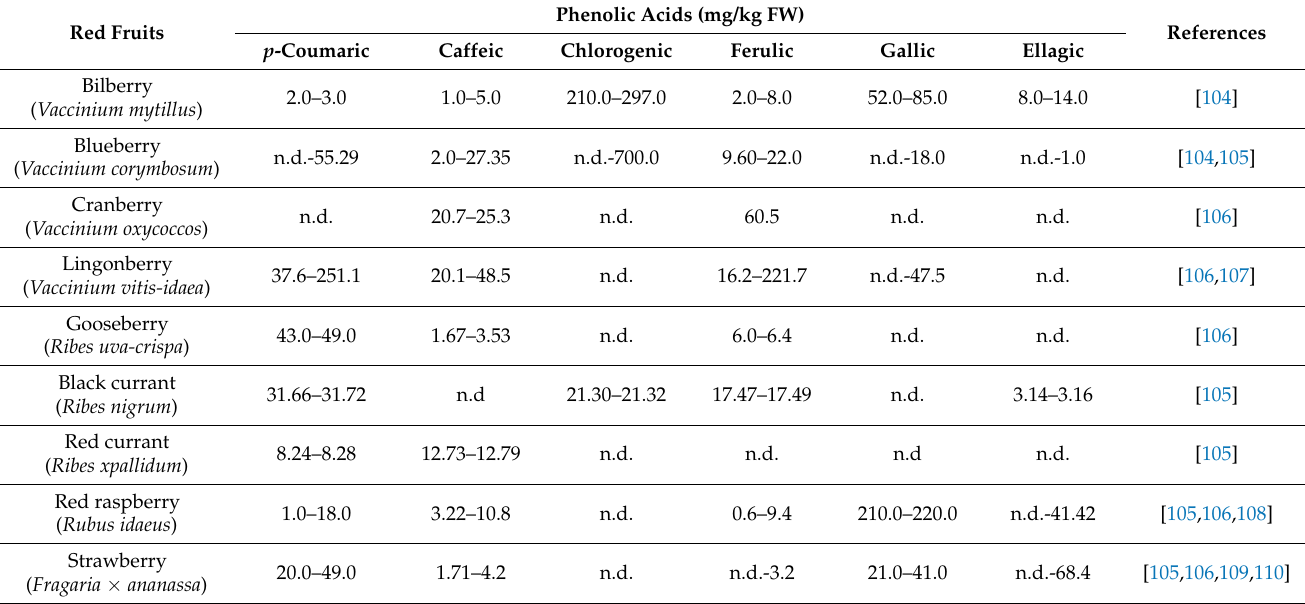
Table 8. Example of phenolic acid contents found in the most common red